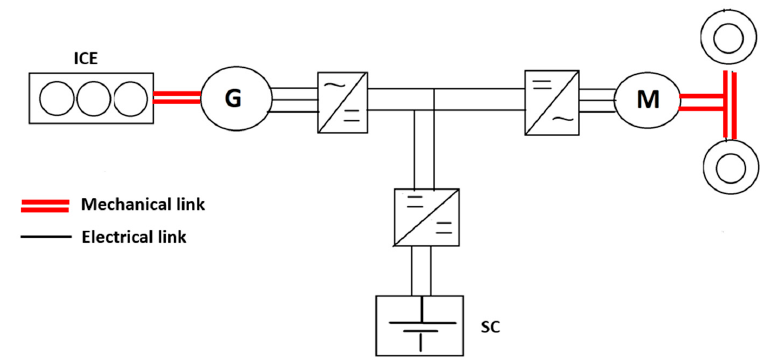
Figure 2. Hybrid series powertrain.